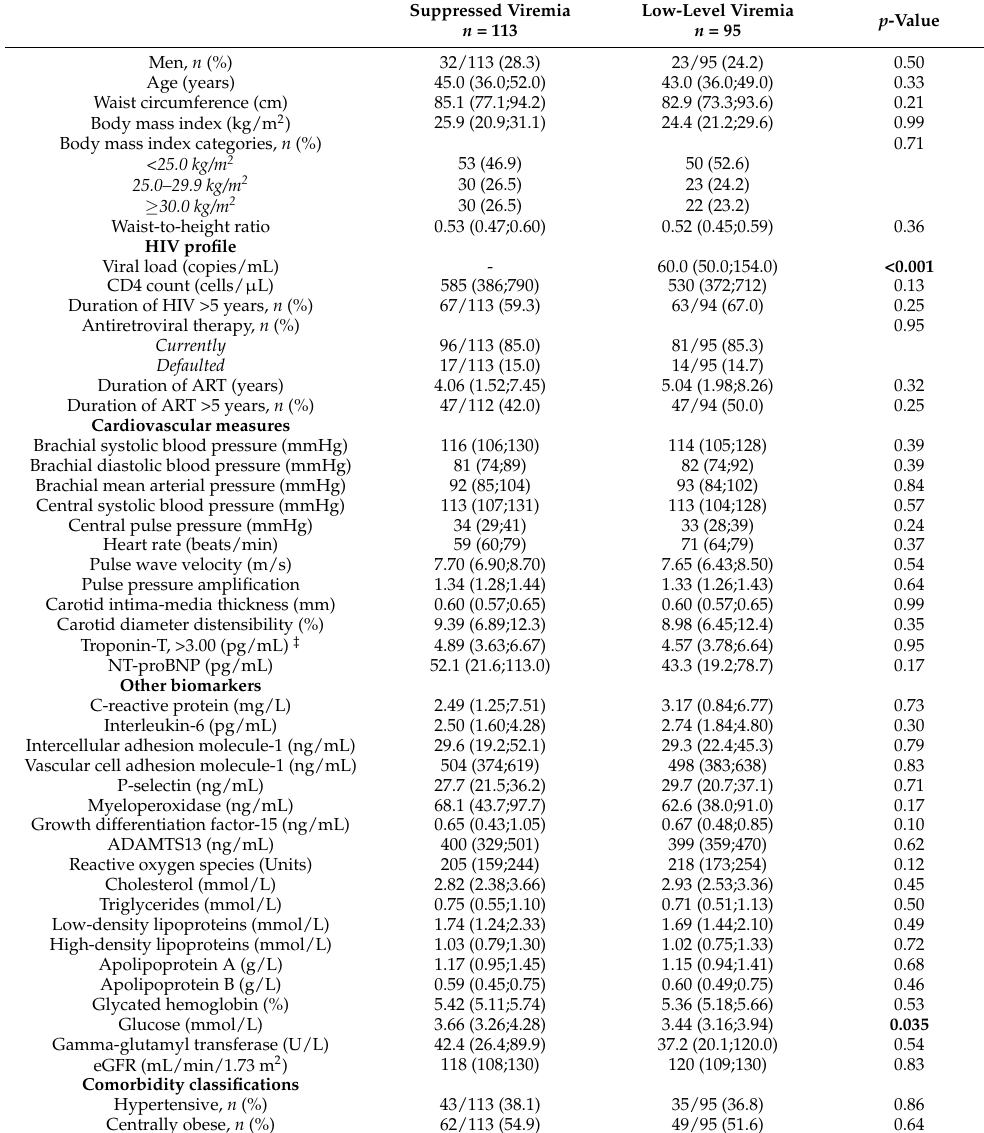
Table 1. Difference in characteristics and cardiovascular measures between people living with HIV and receiving ART, stratified by viremia